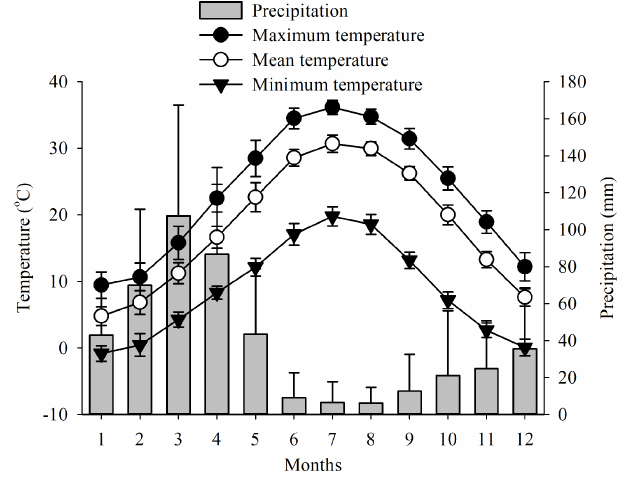
Figure 2. Monthly maximum, mean, and minimum temperature ( o C) as well as total precipitation (mm) at the Drosh weather sta- tion (35.07 ◦ N, 71.78 ◦ E; 1465m), Pakistan